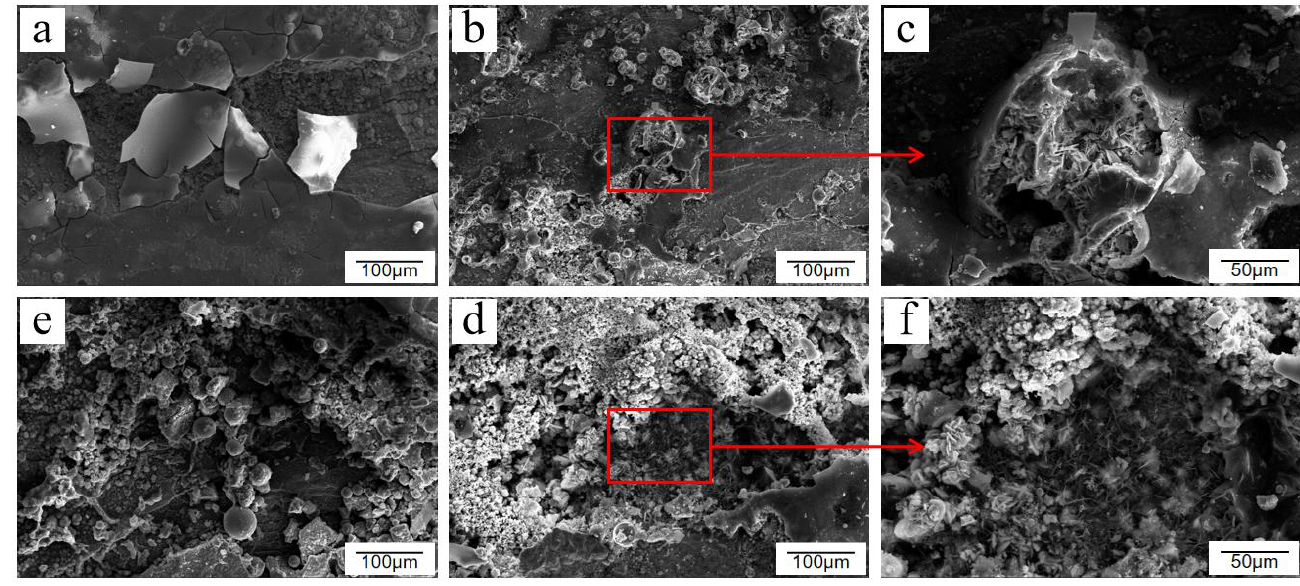
Figure 2. Several corrosion product morphologies of Q235 low-carbon steel under atmospheric conditions: ( a ) membranous, ( b ) needlelike, ( c ) needle enlargement, ( d ) crystal cluster, ( e ) crystal-like, and ( f ) crystal enlargement.